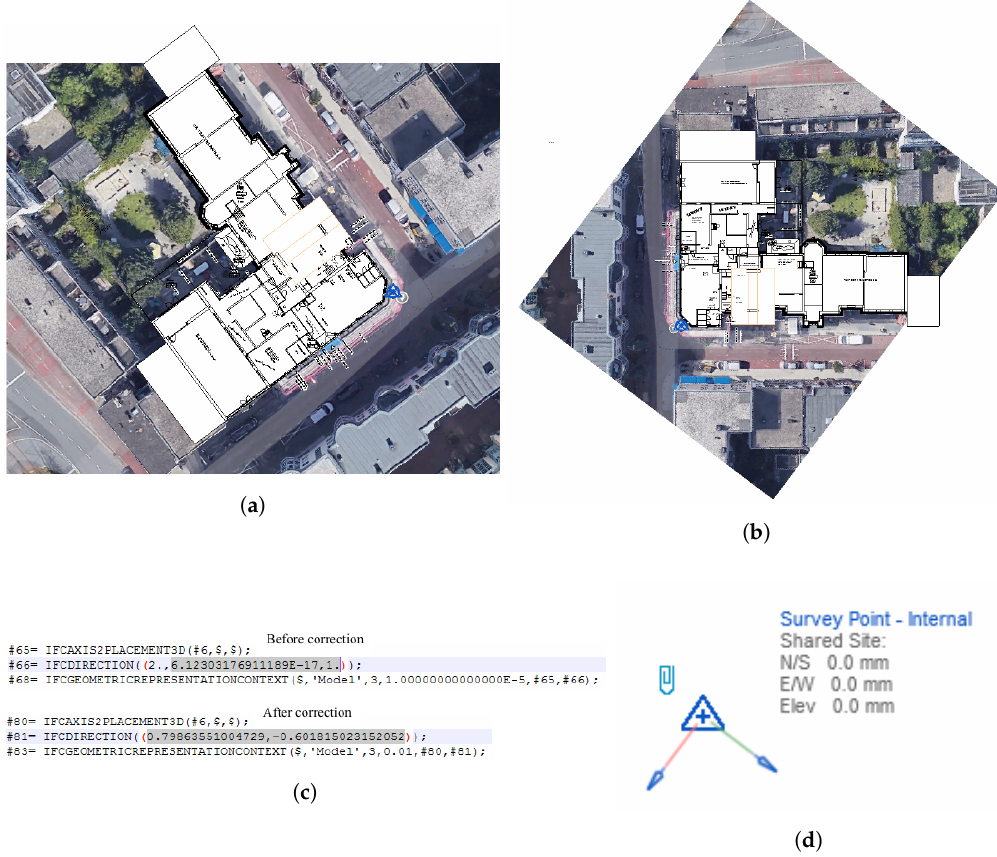
Figure 19. ( a ) Superposed floor plan and image oriented with respect to the true North; ( b ) Superposed floor plan and image oriented with respect to the project North; ( c ) New IfcDirection of the true north; ( d ) New Survey Point of the